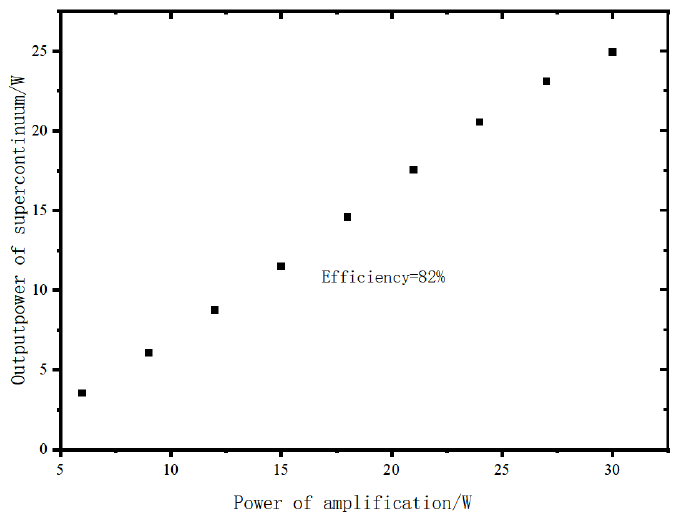
Figure 7. The efficiency curves of pump power and supercontinuum power at the GRIN fiber length of 5 m.